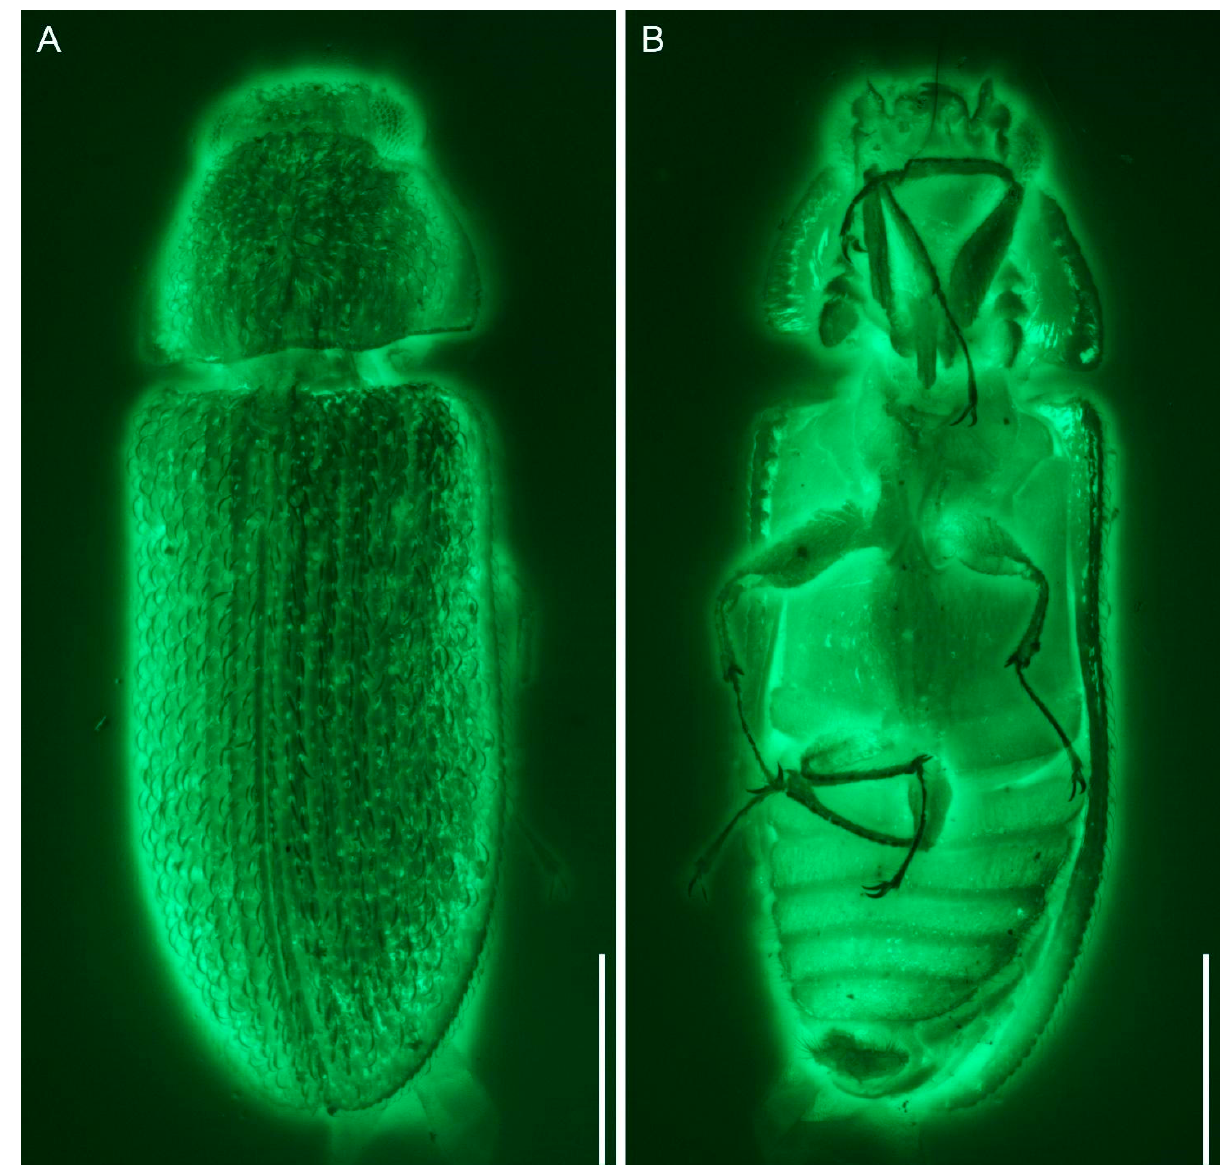
Figure 3. Photograph of Gracilenticrus burmiticus gen. et sp. nov. in Upper Cretaceous amber from Myanmar, holotype (CNU-COL-MA2021001), under widefield fluorescence. ( A ) Dorsal view. ( B ) Ventral view. Scale bars = 0.5 mm.